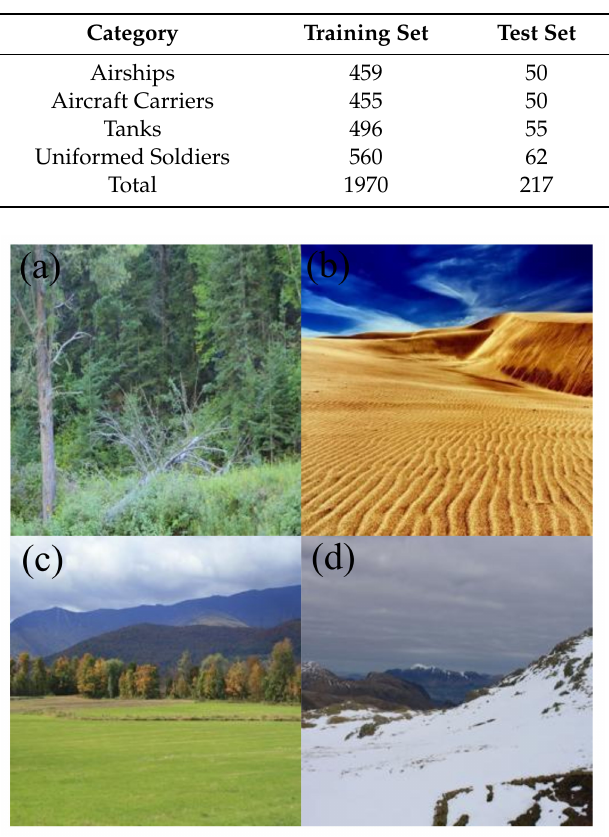
Table 1. Details of the training and test set.